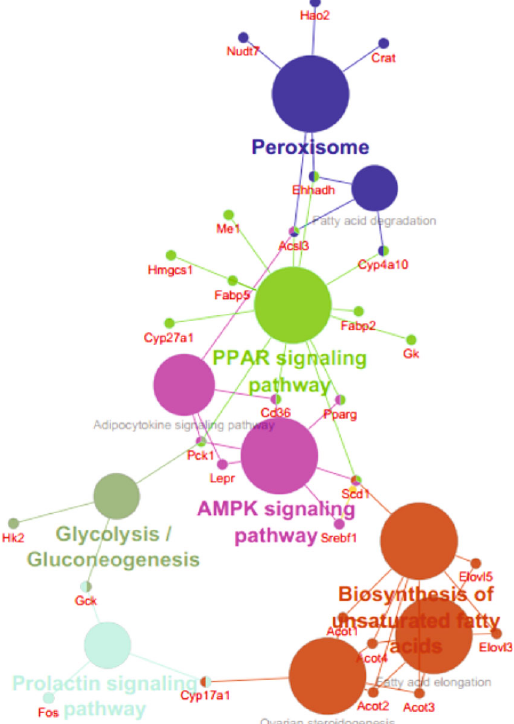
Figure 4: ClueGO results of interconnection between pathways in the network of mouse MAFLD DEGs. Hub pathways are shown as bigger